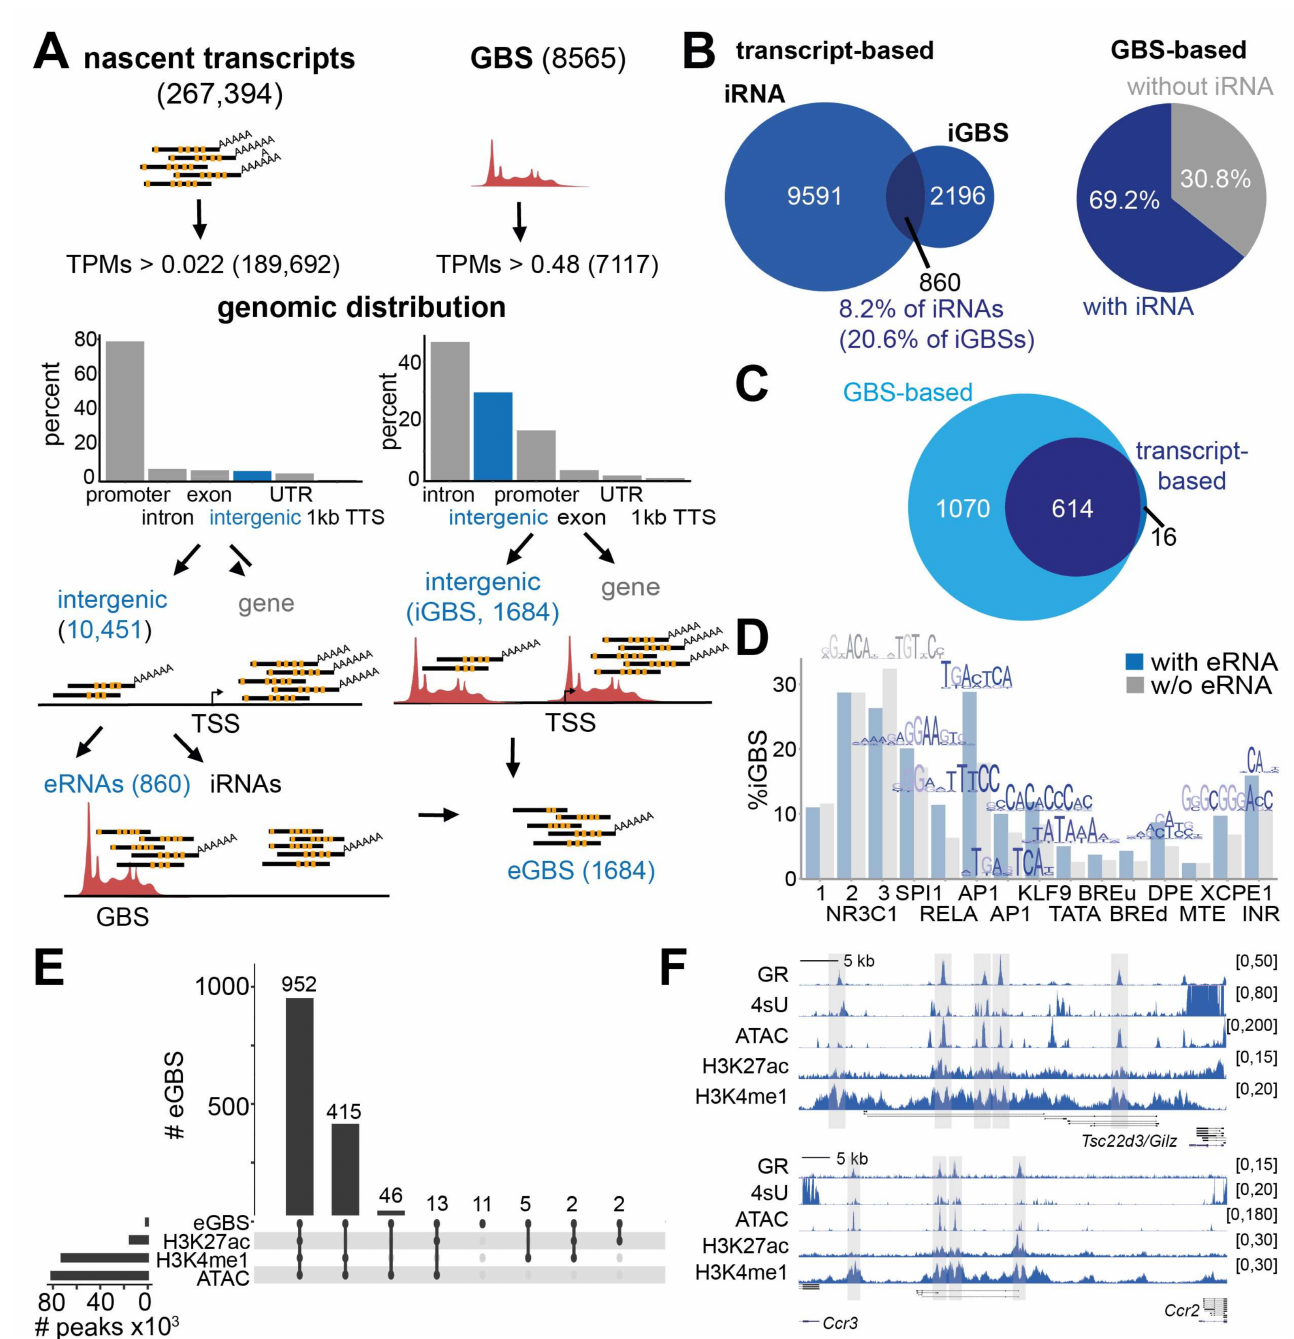
Figure 1. Nascent transcription from GR binding sites in activated macrophages. ( A ) Strategy for eRNA identification based on transcript expression (left, 4sU labeling) and GR binding sites (GBS) (right, ChIP-seq). Brackets show the number of reads or GBSs at each step. Bar plots display the overlap of nascent transcripts (left) or GR binding sites (GBS) with nascent transcription (right) with indicated genomic features. eRNA—enhancer RNA, eGBS—eRNA expressing GBS, iGBS—intergenic GBS, iRNA—intergenic RNA, TPMs—transcripts per million, TSS—transcriptional start site,